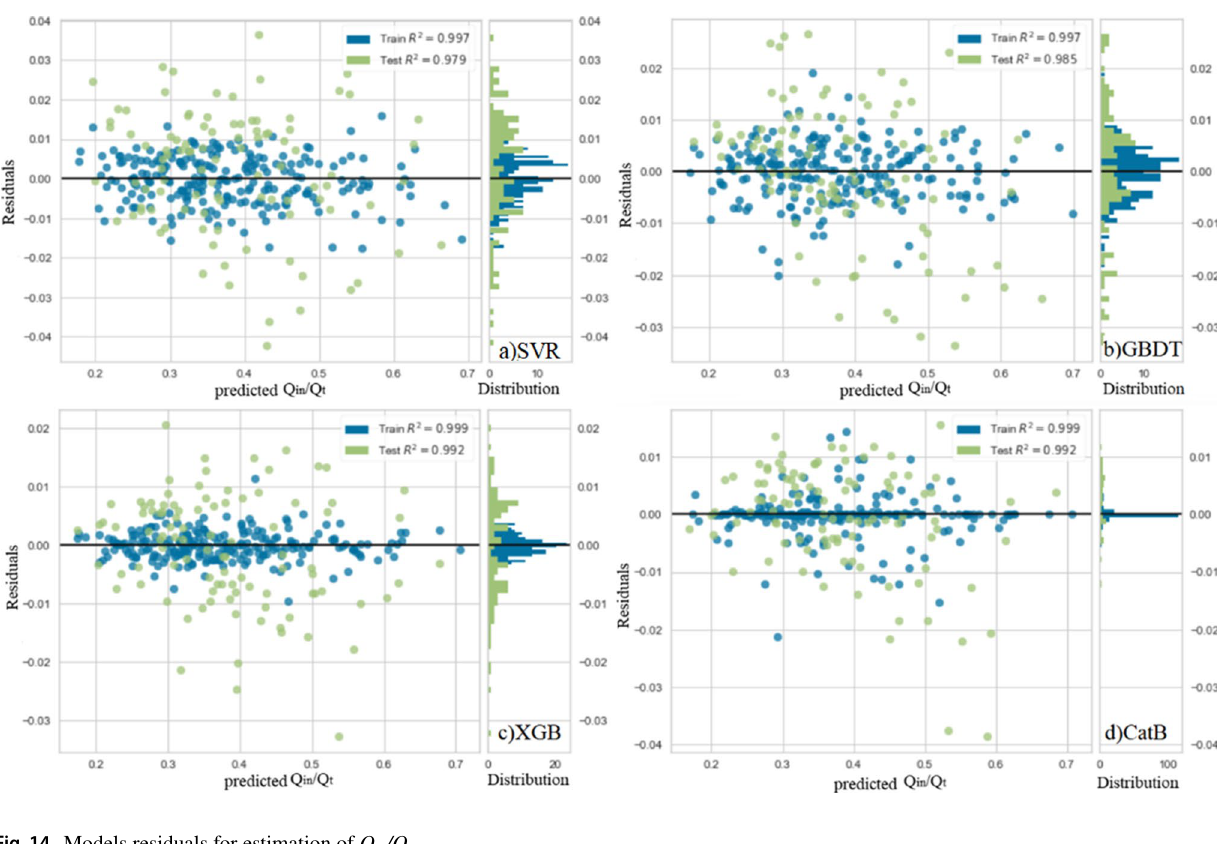
Fig. 14 Models residuals for estimation of Q